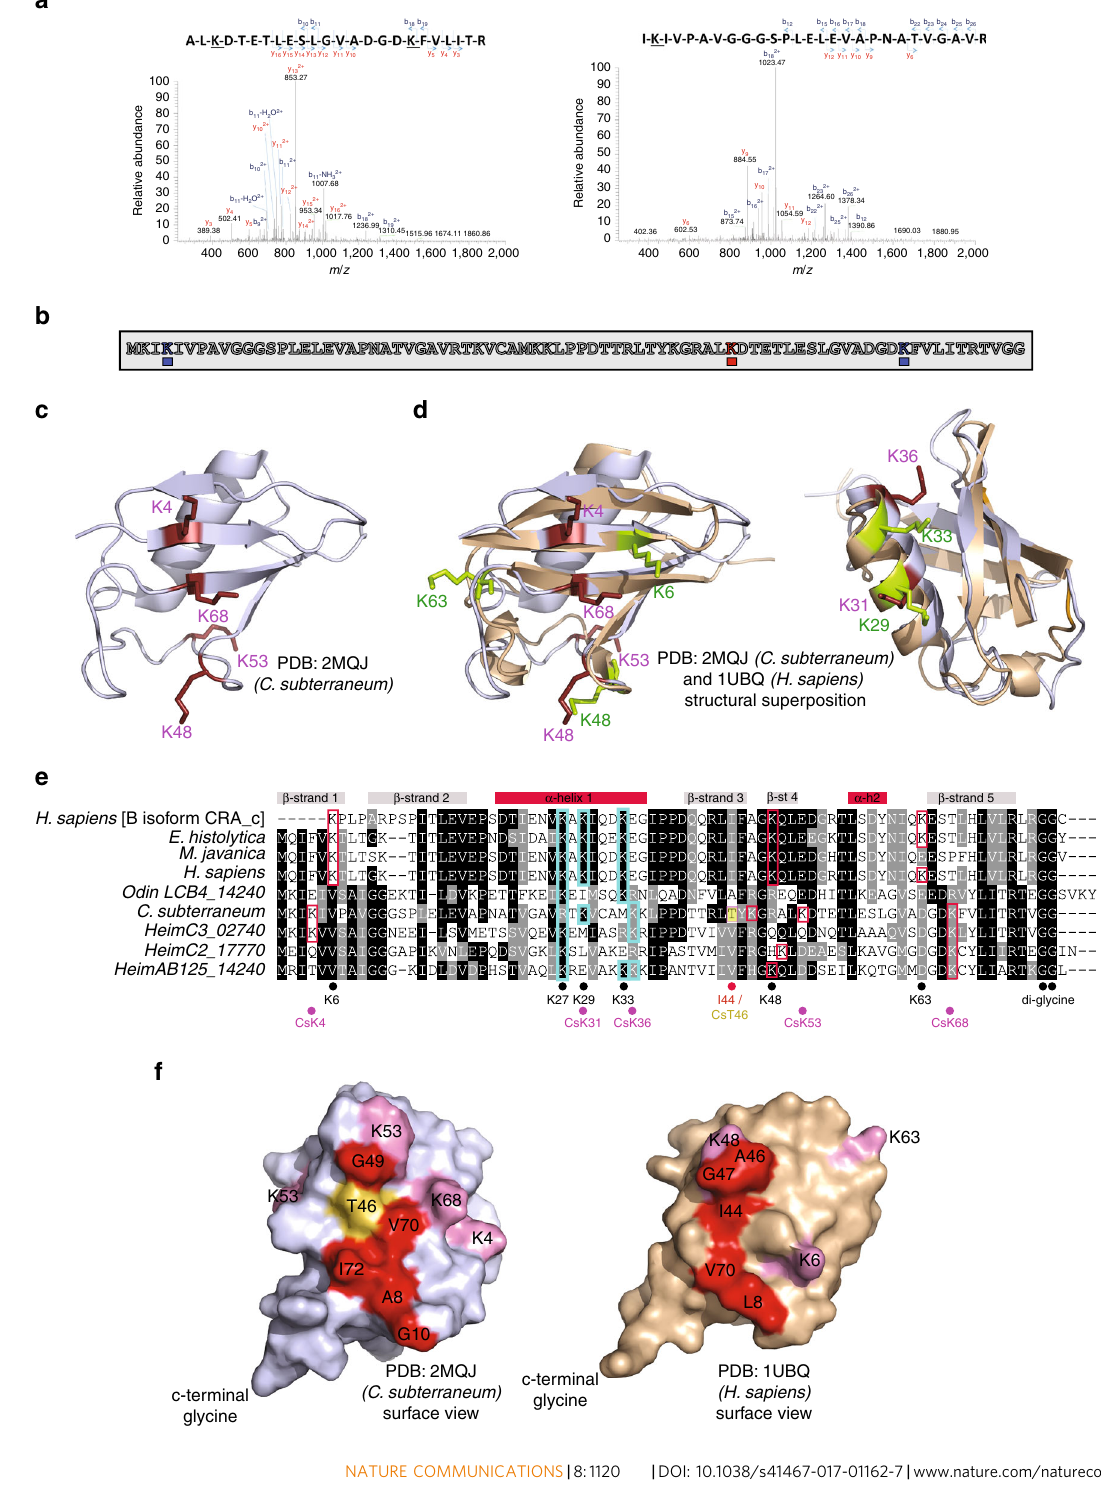
PDB: 1UBQ (H. sapiens)